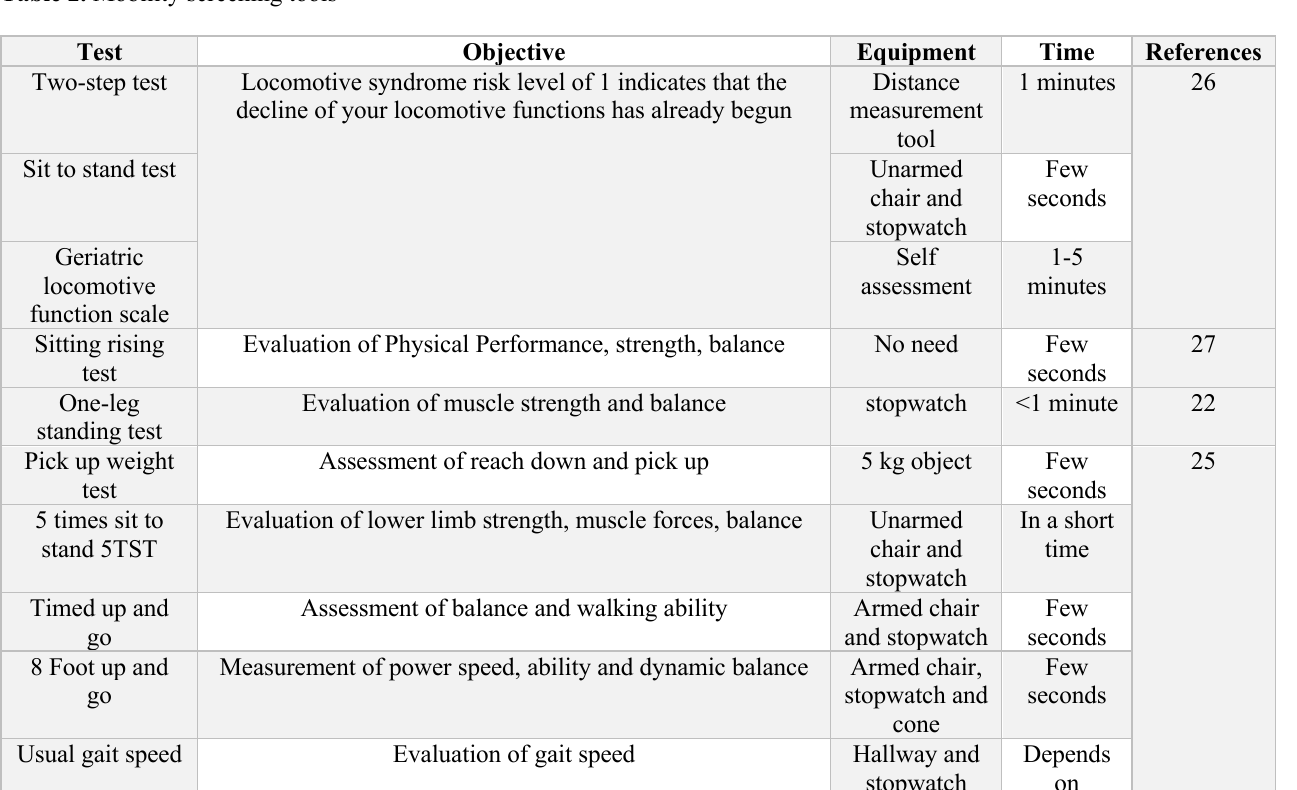
Table 2. Mobility screening